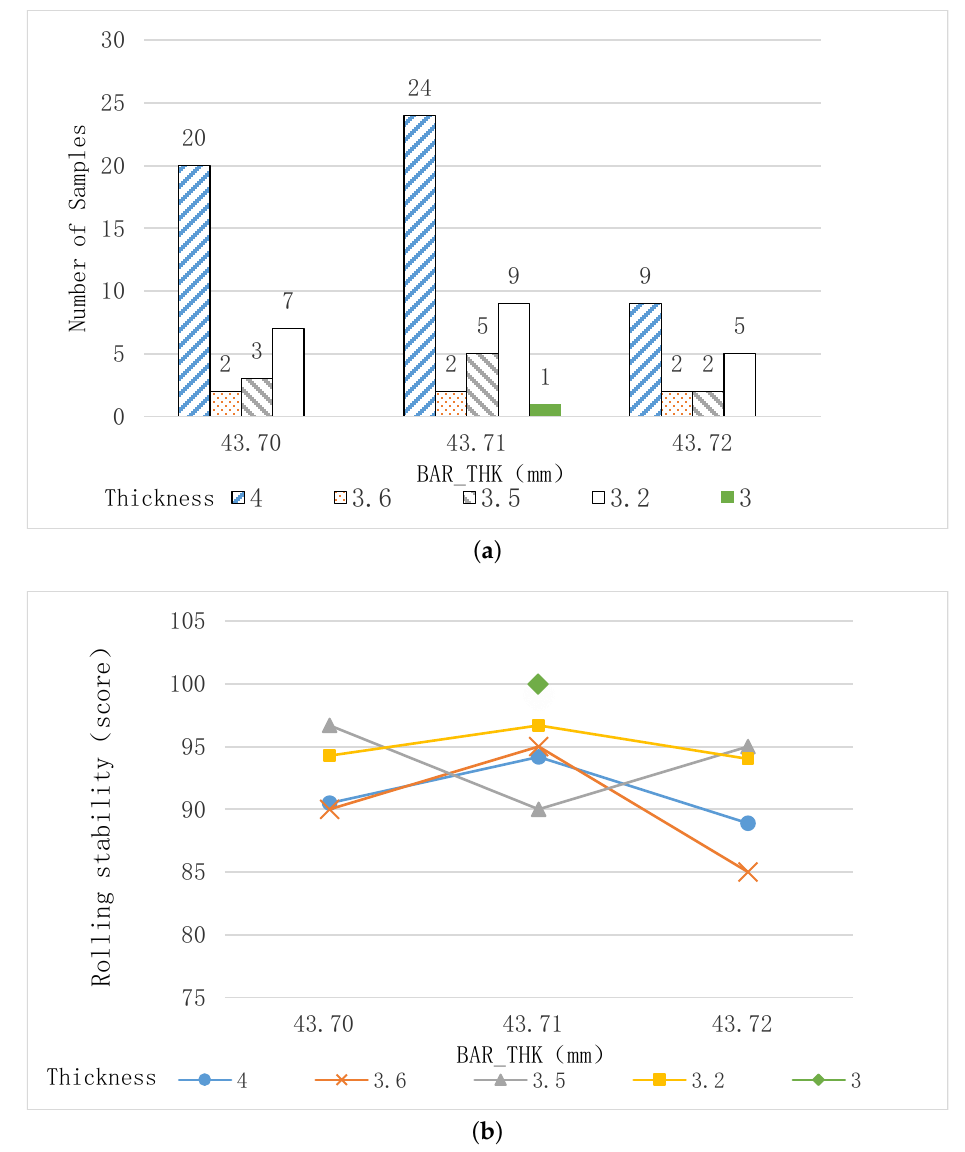
Figure 7. Thickness of intermediate billet. ( a ) Sample distribution; ( b ) Stability